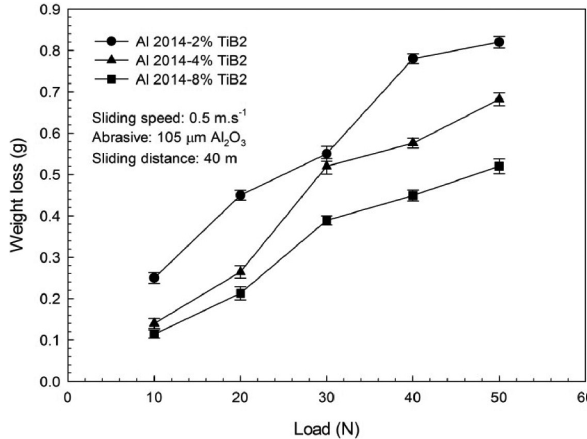
Fig. 8: The change in weight loss as a function of applied